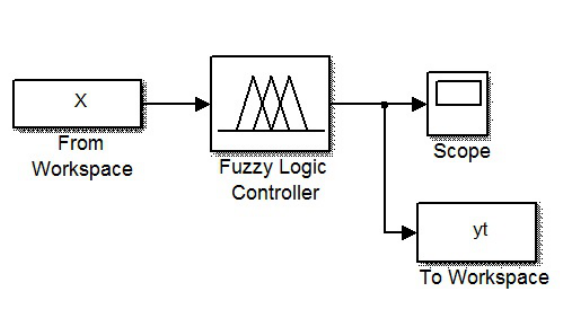
Figure 7: Fuzzy logic model in Matlab.